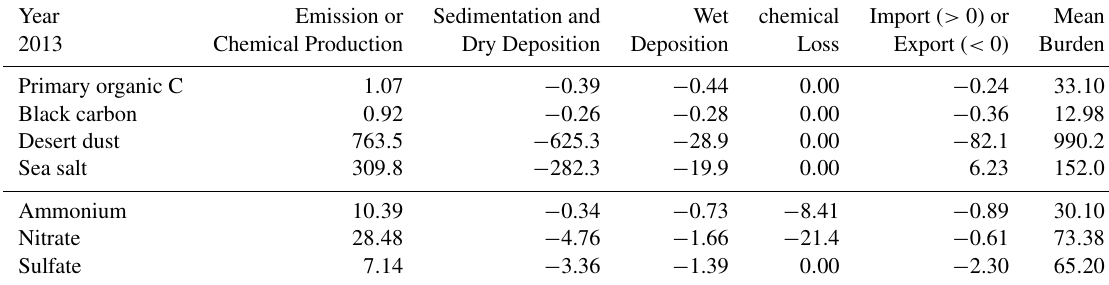
Table 11. Same as Table 10 but for